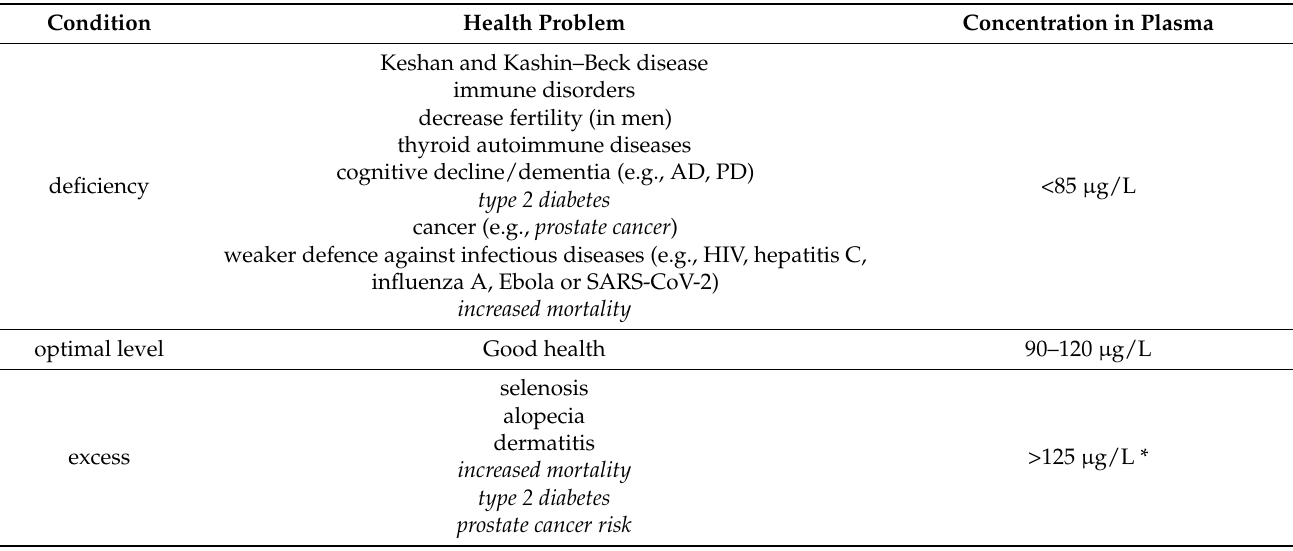
Table 1. The main health problems connected with selenium deficiency or excess